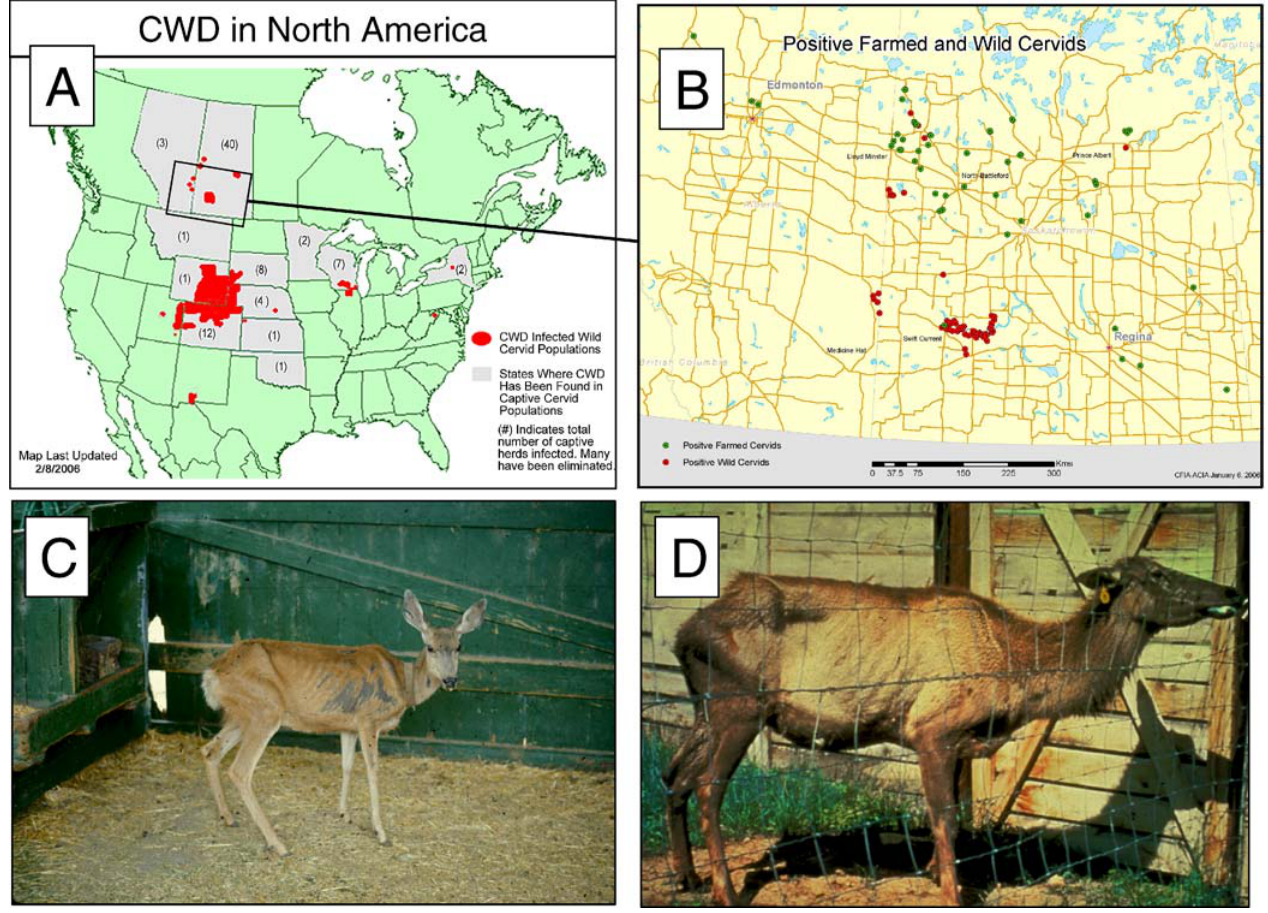
DOI: 10.1371/journal.ppat.0020026.g004 Figure 4. CWD in North America Geographical distribution in North America (A), and in expanded view of Alberta and Saskatchewan (B). Data in (A) is correct as of February, 2006, and reproduced with kind permission of the CWD Alliance. In (A), states or provinces where CWD has been diagnosed in captive populations are cross-hatched. CWD diagnosis in free-ranging animals is indicated by red circles. In (B), CWD diagnosis in free-ranging animals is indicated by red circles and in farmed animals with green circles. (C) Mule deer with clinical CWD showing emaciation and loss of body condition (photo courtesy of T. R. Spraker). (D) Elk with clinical CWD showing emaciation and excessive salivation (photo courtesy of E. S. Williams). PLoS Pathogens |